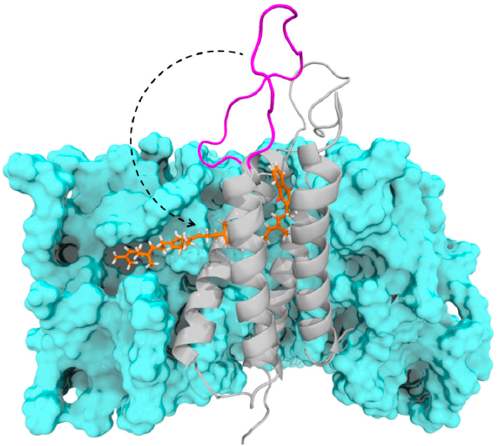
Figure A3. Vitamin MK7 hydrophobic tail interactions with the membrane. The three-dimensional vitamin K epoxide reductase (VKORC1) structure is shown as a grey image, with vitamin MK7 E as orange sticks. The membrane is depicted as a light blue surface. The black dashed arrow indicates the location of the magenta loop part which is embedded into the membrane with respect to the VKORC1 structural models developed by Oldenburg [30] and Li [39].